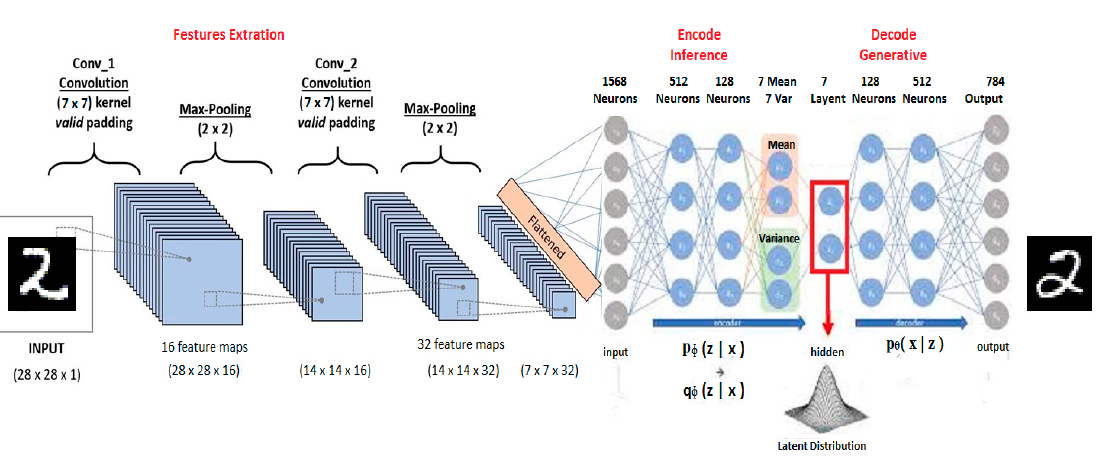
Figure 4. Generator model, based on a variational autoencoder with 2 convolutional layers for feature extraction, an encoder, and a decoder network.